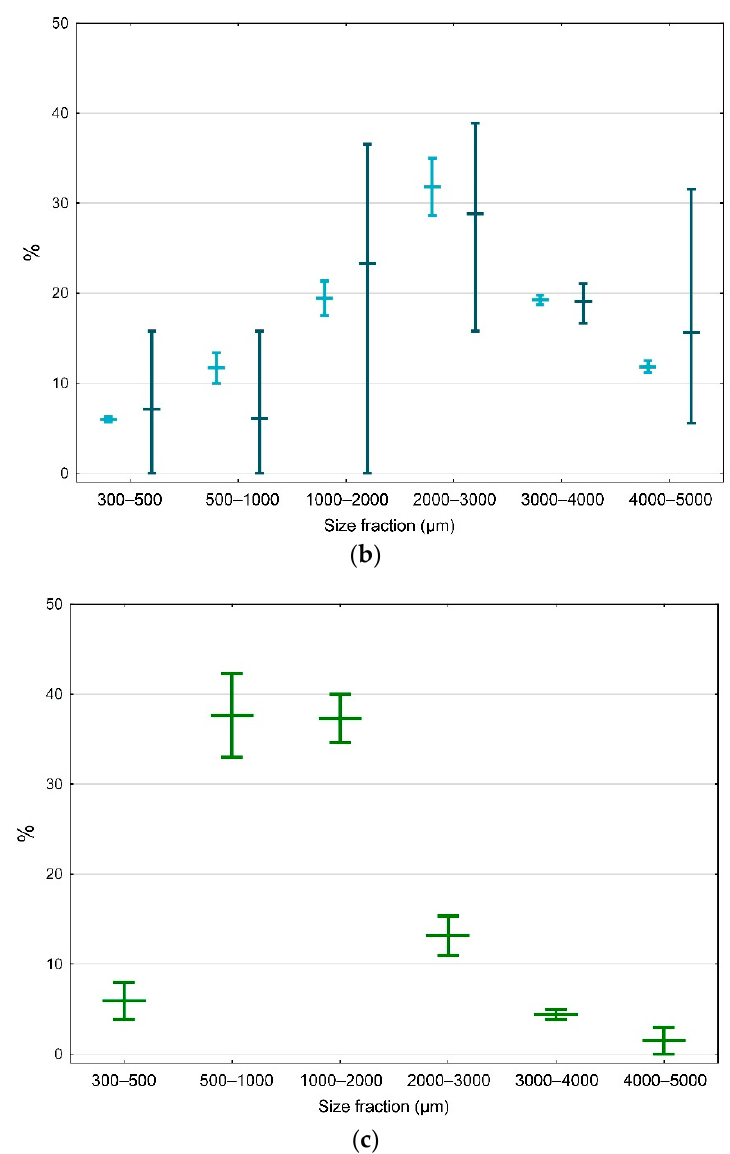
Figure 3. Percentage of contribution of microplastics size fraction (300–500 µm, 500–1000 µm, 1000–2000 µm, 2000–3000 µm, 3000–4000 µm and 4000–5000 µm) to the total sampled fraction (>300 µm) at the different sites ( a ) TLN: Toulon, ( b ) GEN: Genova and ( c ) OLB: Olbia and seasons (W: winter and S: summer). Average is represented by horizontal bars and minimum and maximum values represented by whiskers.